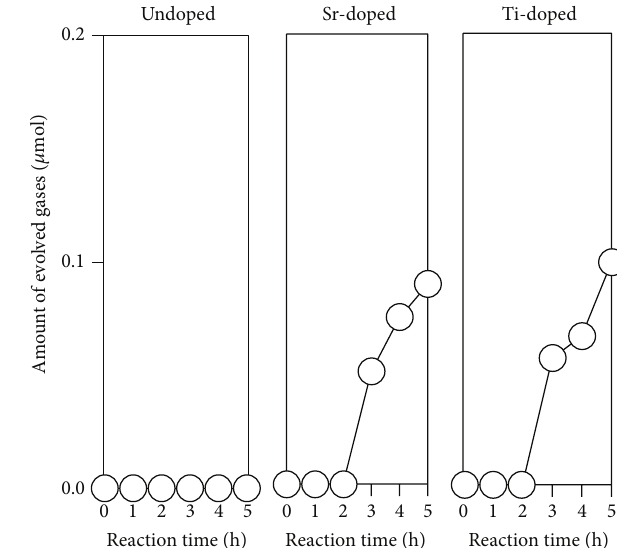
Figure 3: SEM images of LaNbON 2 synthesized by the ammonothermal method (a) and by nitridation of an oxide precursor (b).